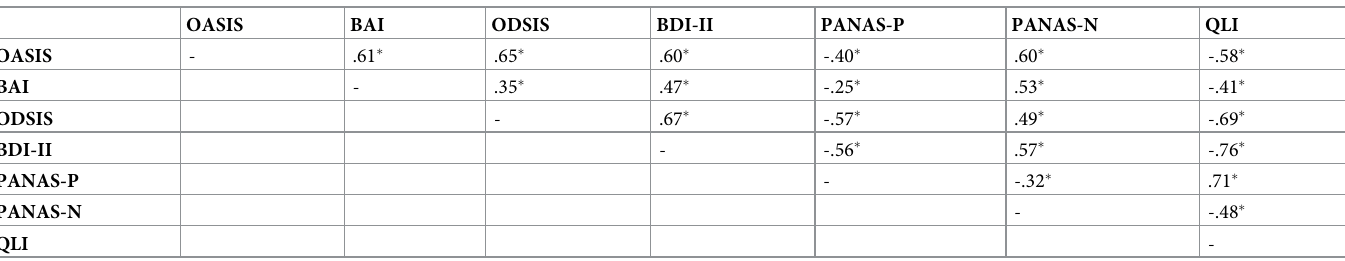
Table 5. Correlations of the OASIS with convergent validity